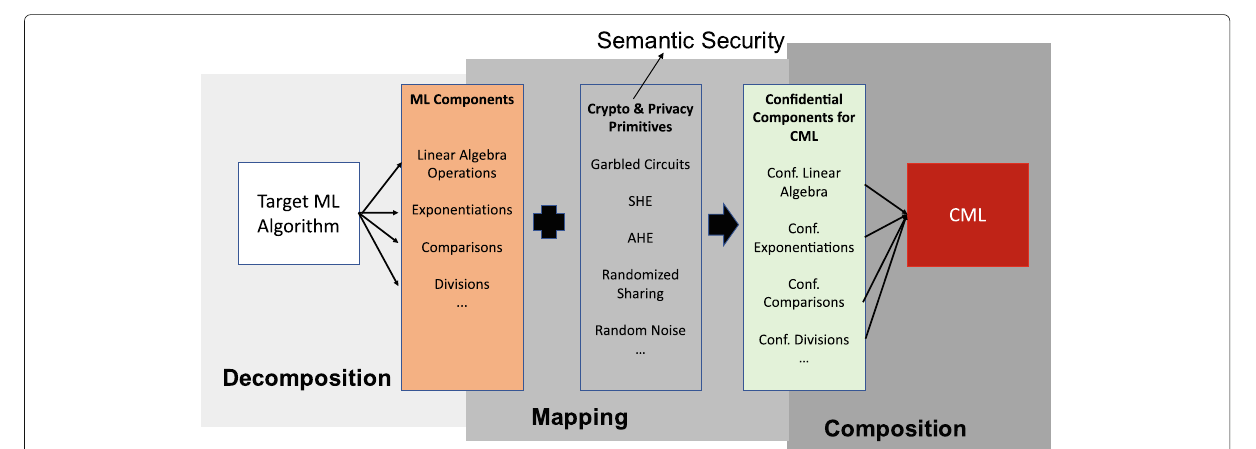
Fig. 4 The decomposition-mapping-composition (DMC) process for constructing hybrid CML